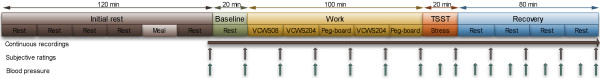
Experimental protocol. The continuous recordings were electromyogram, electrocardiogram, skin conductance and respiration. Subjective ratings comprised pain intensity ratings and the stress-energy questionnaire.